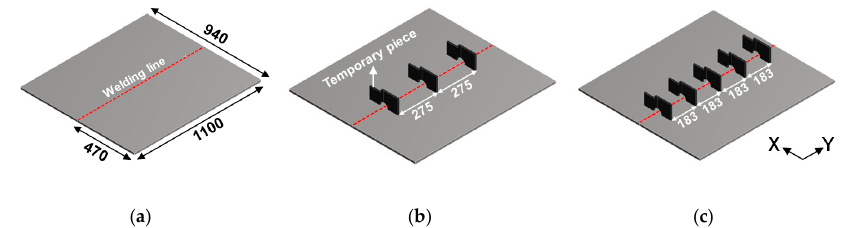
Figure 4. Welding test specimens for three experimental cases: ( a ) specimen 1; ( b ) specimen 2; and ( c ) specimen 3. Table 1. Operation conditions of butt welding.